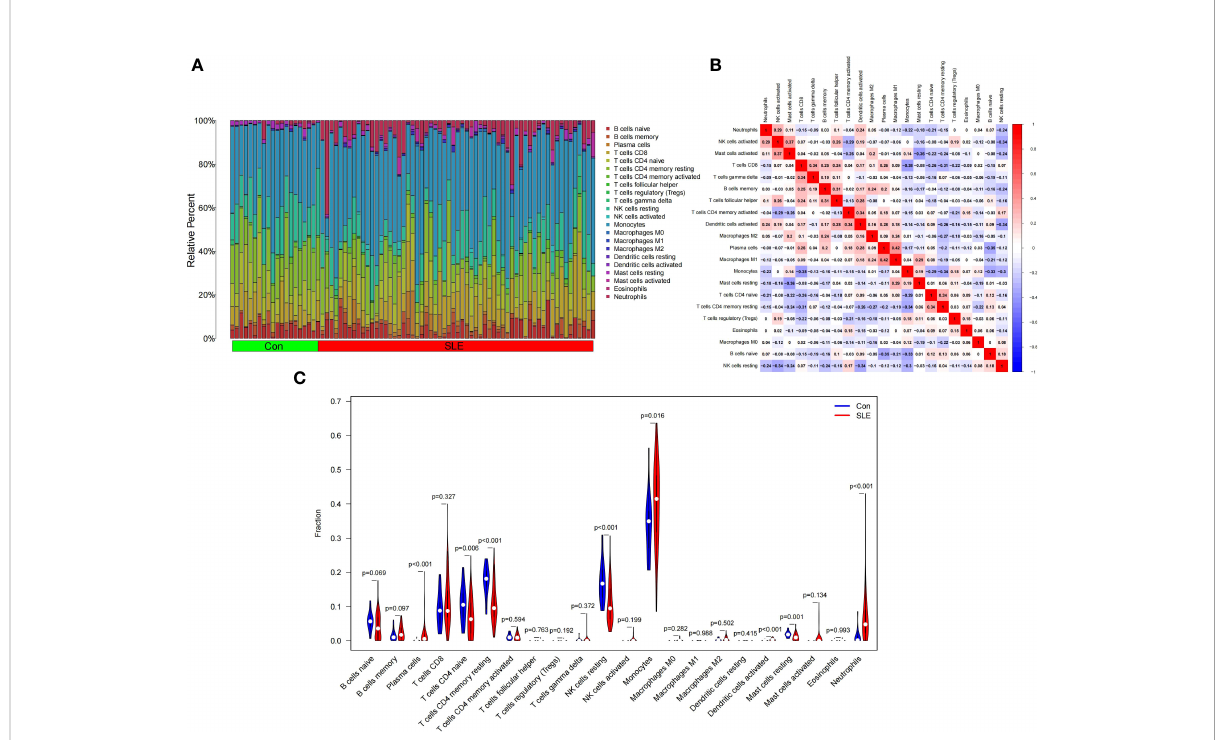
FIGURE 8 Landscape map of in fi ltrating immune cells (IICs) in the Systemic Lupus Erythematosus (SLE) and Con groups. (A) The relative proportion of IICs in SLE and Con. (B) Correlation heatmap between IICs. Red represents positive correlation, blue represents negative correlation, and the number in the square represents correlation. (C) Violin diagram showing the difference in immune cell in fi ltration between SLE and Con. (SLE group shown in red, Con group shown in blue, p < 0.05 was considered statistically signi fi